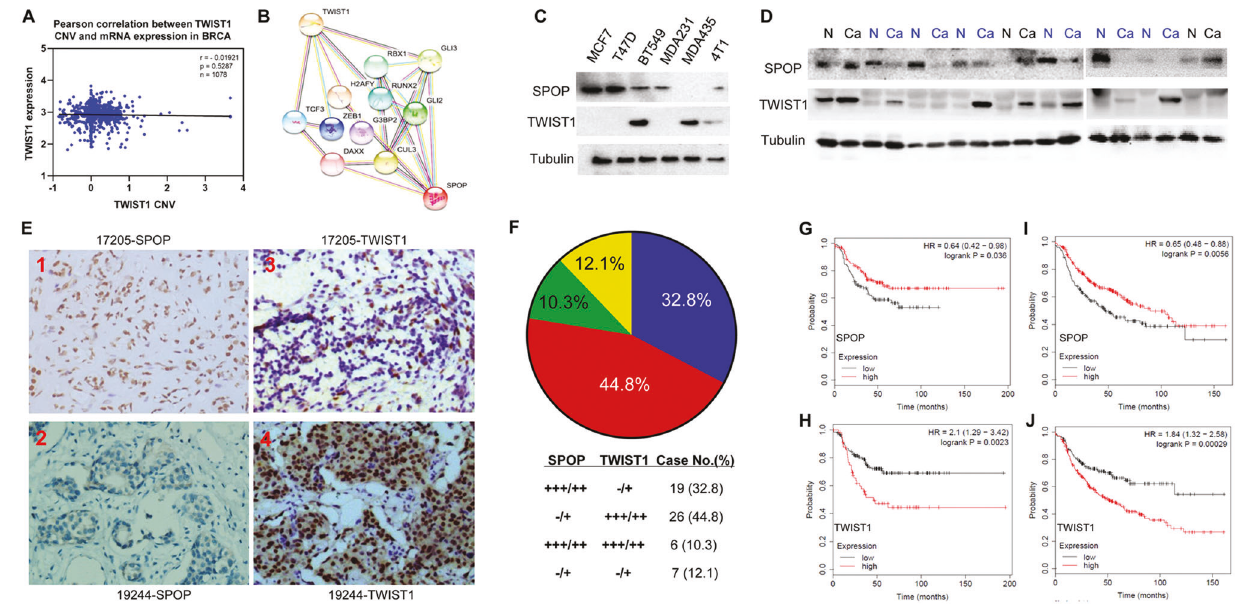
Fig. 1 Expression of SPOP and TWIST1 is reversely correlated with invasive human breast carcinoma tissues, and associated with breast cancer patient survival among TNBC, positive lymph node status and high grade. A Analysis of TCGA breast cancer data. Pearson correlation between TWIST1 mRNA expression and CNV in TCGA breast cancer. B Analysis of STRING Interaction Network to discover a potential link between TWIST1 and SPOP. C Protein expression levels for SPOP and TWIST1 in breast cancer cell lines. D Western blotting analysis for SPOP and TWIST1 protein expression in nine invasive ductal breast cancer tissues and their matched normal tissues. TWIST1 protein expression was inversely correlated with SPOP protein expression in the breast tumor tissues. E Representative Immunohistochemical (IHC) of indicated TWIST1 and SPOP in the tissues. Representative IHC for SPOP in tissue sample No. 17205 (1) and No. 19244 (2) respectively. Representative IHC for TWIST1 in tissue sample No. 17205 (3) and No. 19244 (4) respectively. F Reverse correlation of protein expression of SPOP and TWIST1 in breast invasive ductal carcinoma specimens. G High SPOP protein expression is positively correlated with patient survival of TNBC. H High TWIST1 protein expression is inversely correlated with patient survival of TNBC. I High SPOP protein expression is positively correlated with patient survival in both positive lymph node status and high grade. J High TWIST1 protein expression is inversely correlated with patient survival in patients with both positive lymph node status and high